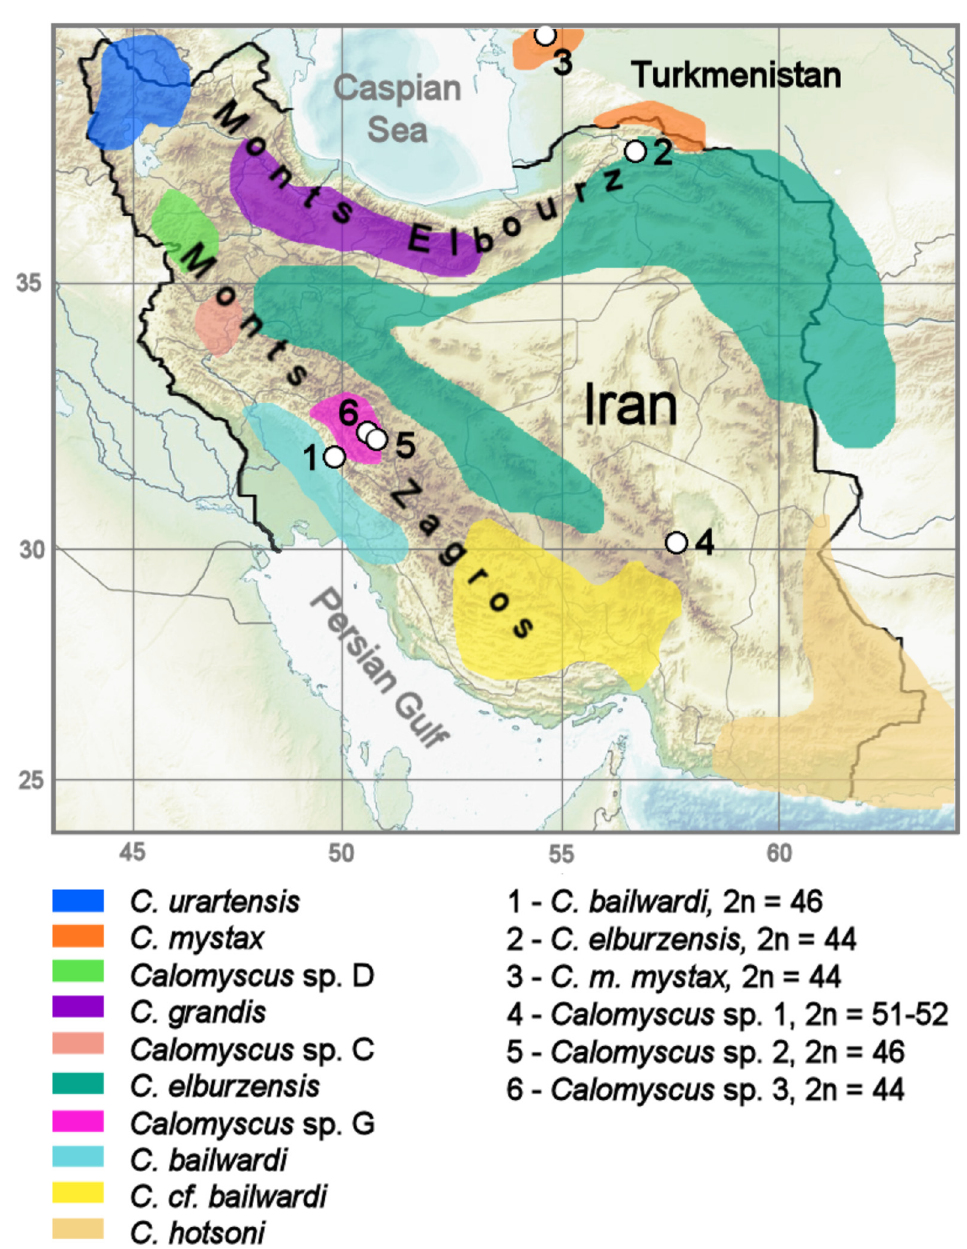
Figure 1. Geographic position of the localities studied: 1—Izeh, Khuzestan Province, Iran, 2—Korkhout Mt., North Khorasan Province, Bojnourd, Iran, 3—Maly Balkan Gershi (Arlandag) Mt., Bolshoi Balkhan, Turkmenistan, 4—Shahdad tunnel, Kerman Province, Iran, 5—Aloni and Cheshme Maiak, Shahr-e-Kord—Soreshjan, Chahar Mahal and Bakhtiaria Province, Iran, 6—southeastern ridge Zard-Kuh Mts., Isfahan Province, Iran. For detailed localities description see